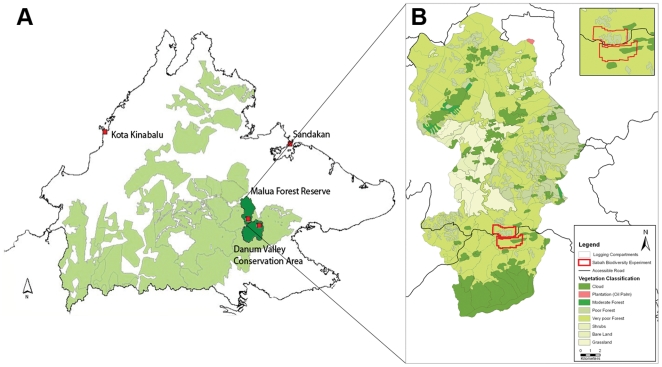
Map of Sabah and forest quality map of Malua Forest Reserve.(A) Allocated production forest is shown across Sabah (light green, also including Malua Forest Reserve). The study sites (marked in red) are located in the Malua Forest Reserve and the Danum Valley Conservation Area (dark green). (B) Forest quality map of the Malua Forest Reserve (visual interpretation of aerial photographs, 1∶17,500). The boundary of the Sabah Biodiversity Experiment (500 ha) is outlined (red). Forest classification is based on number of trees ≥60 cm DBH derived from crown size. Cloud forest: >16 trees ha−1, Moderate: 9–16 trees ha−1, Poor: 5–8 trees ha−1, Very Poor: 1–4 trees ha−1, Shrubs/Bare Land/Grassland: none, Plantation: Oil palm monoculture.